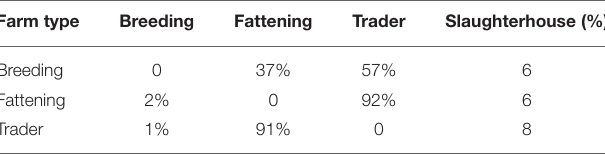
TABLE 3 | Number of pigs traded between every two classes of farms. Farm type